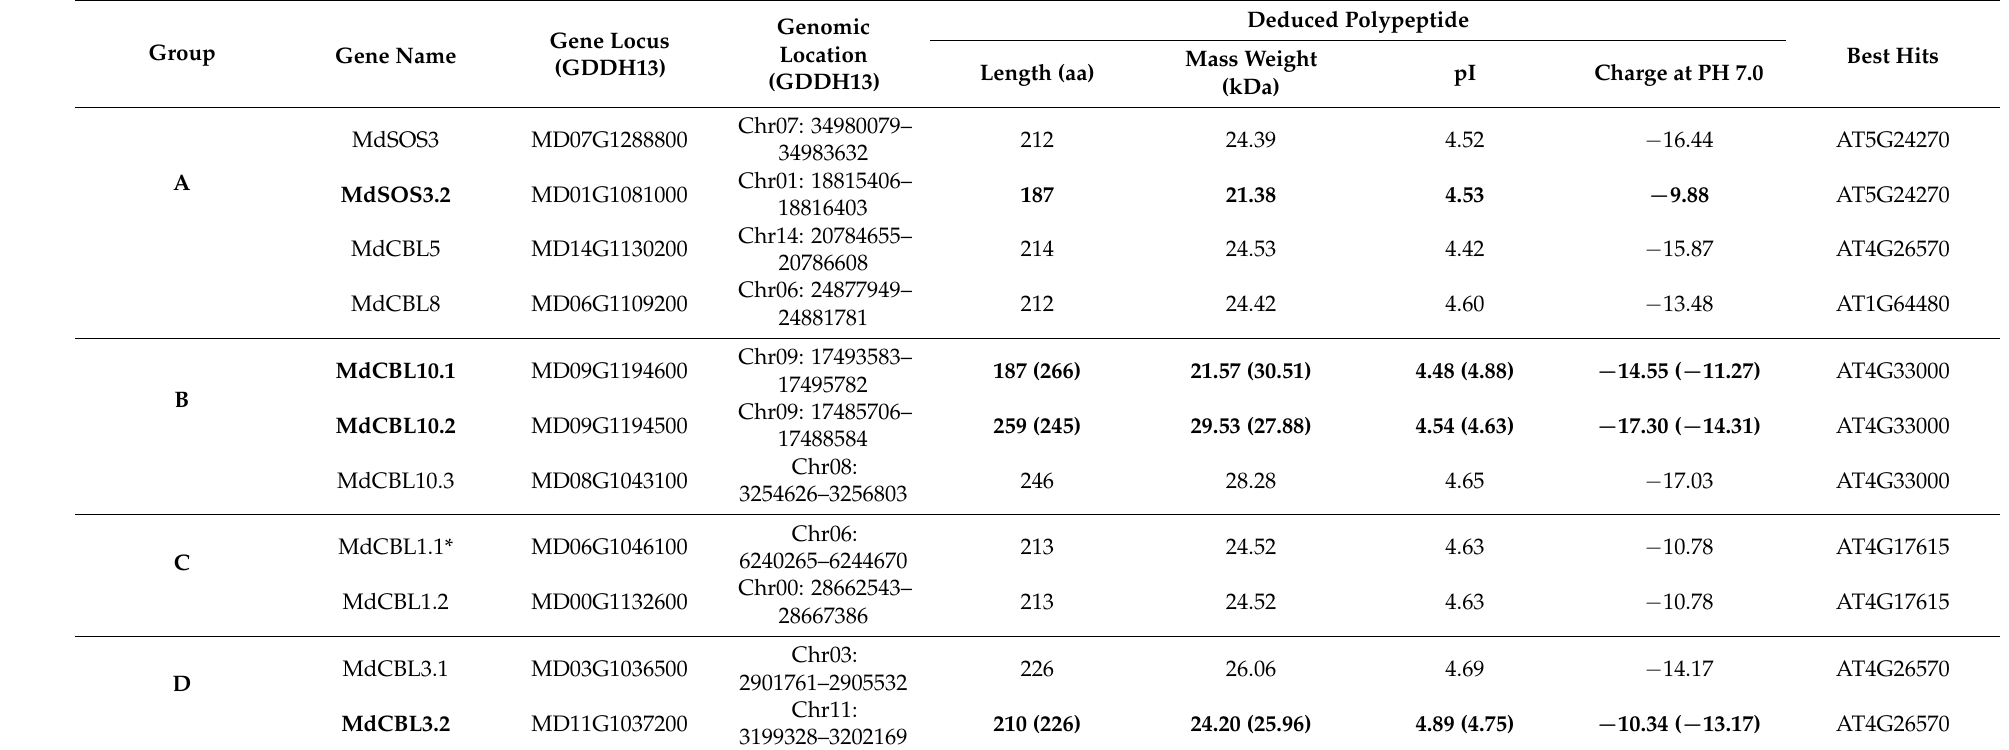
Table 1. Characterization of the CBL family genes in